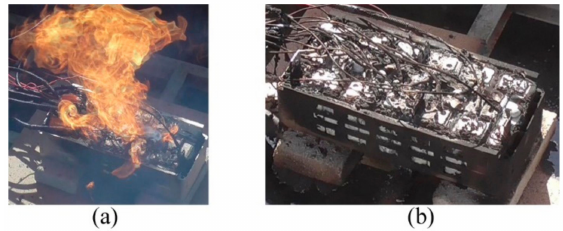
Figure 7. Harness burning and module debris: ( a ) harness burning and ( b ) module debris.